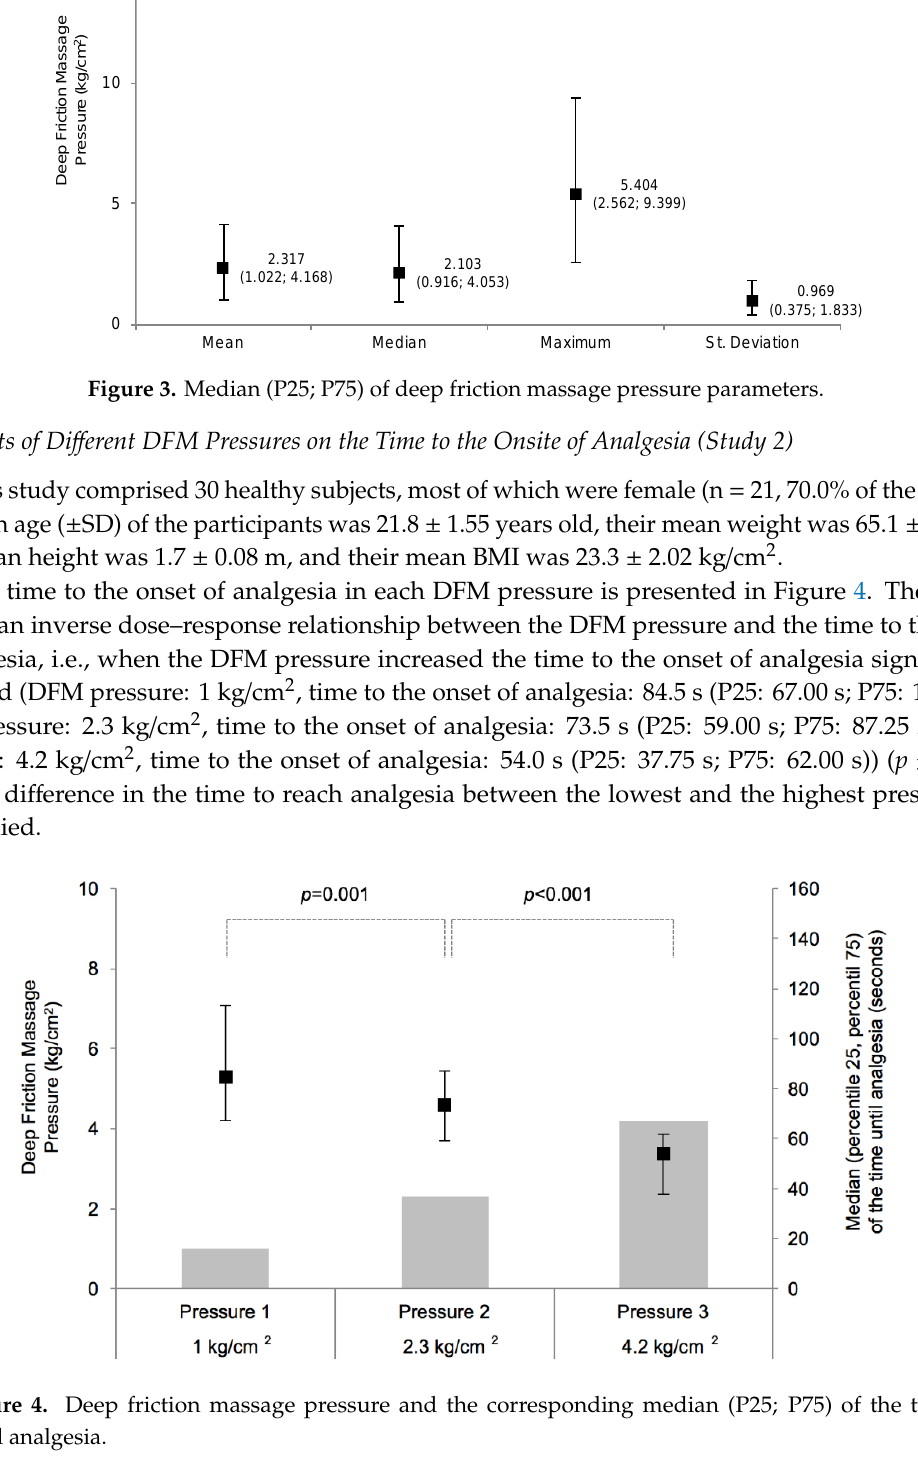
Figure 4. Deep friction massage pressure and the corresponding median (P25; P75) of the time until analgesia.